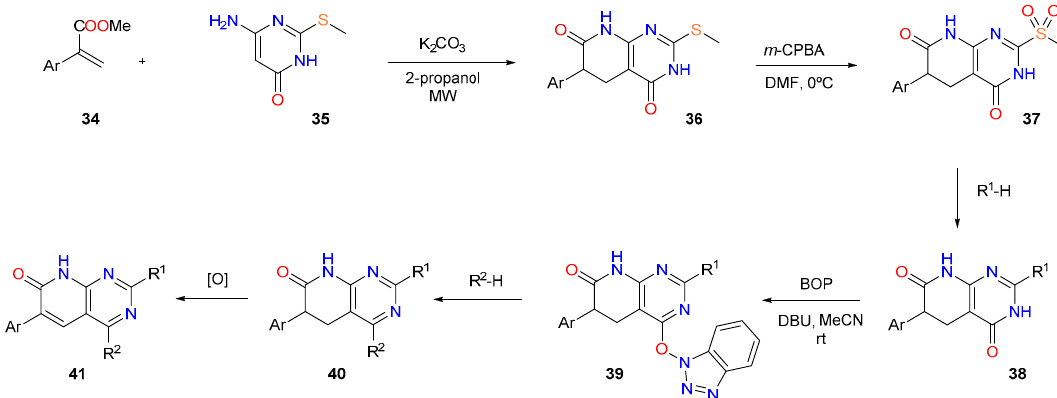
Figure 15. Synthesis of the substituted pyrido[2,3- d ]pyrimidin-7(8 H )-one ( 41 ) from the pyrimidinone 35 .